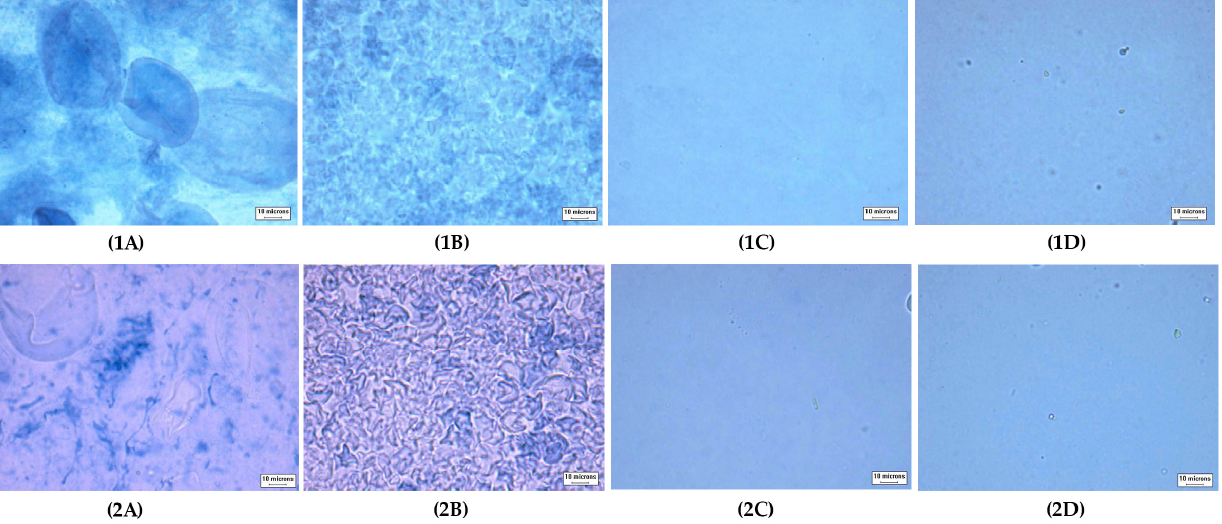
Figure 5. Microstructure of cooked starch pastes (RVA preparation) (40×, bar = 10 μ m). Uppercase letters indicate type of starches: ( A ) TS, ( B ) RS, ( C ) WTS, and ( D ) WRS. The number indicate the system used to prepare starch gels; ( 1 neutral system and ( 2 ) sugar–acid system. ( 1A ): TS paste